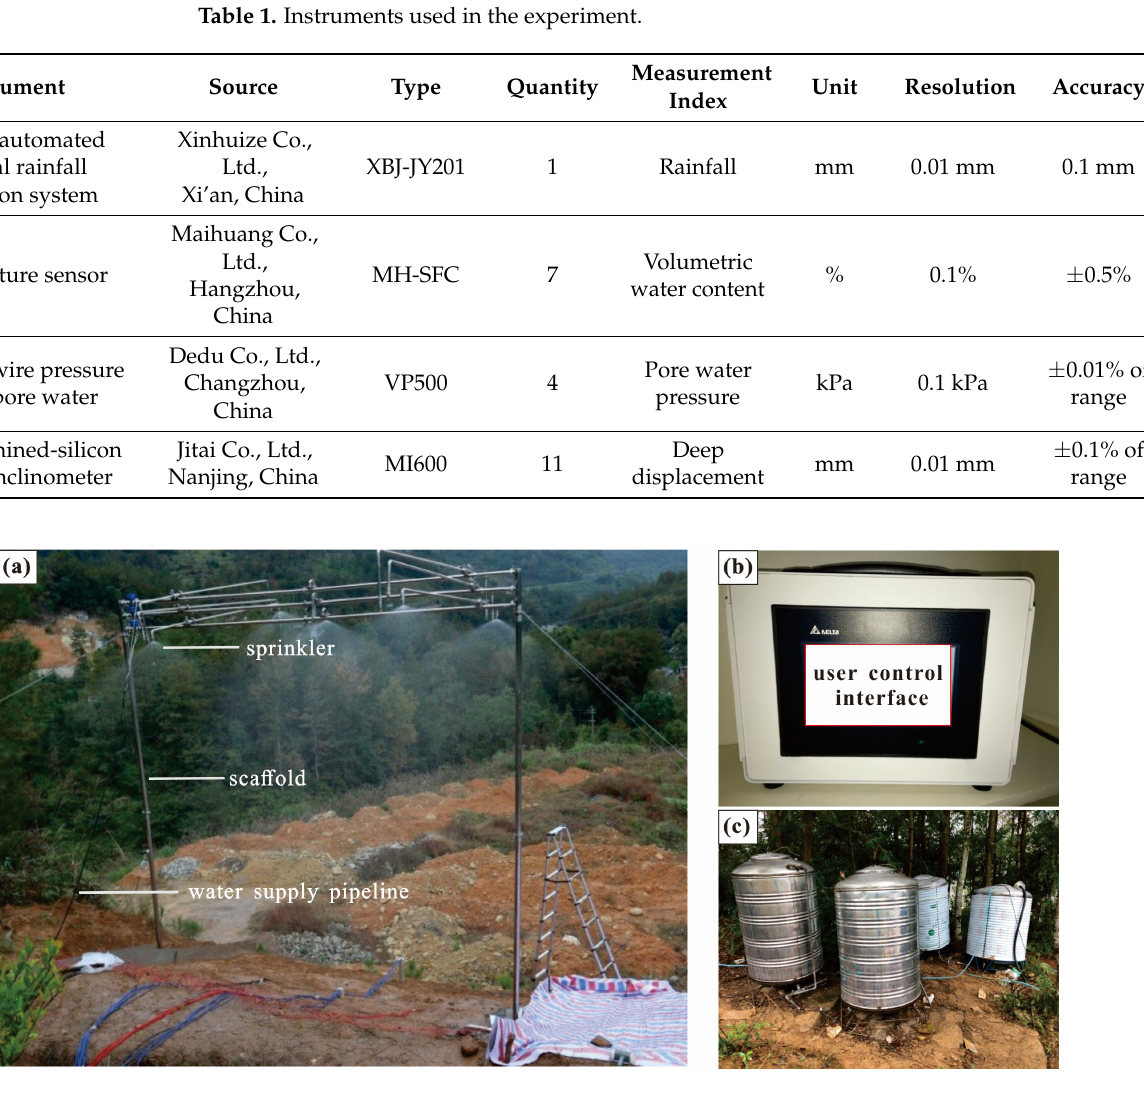
Figure 3. Automatic artificial rainfall simulation system: ( a ) General layout; ( b ) Control system; ( c ) Water tanks.